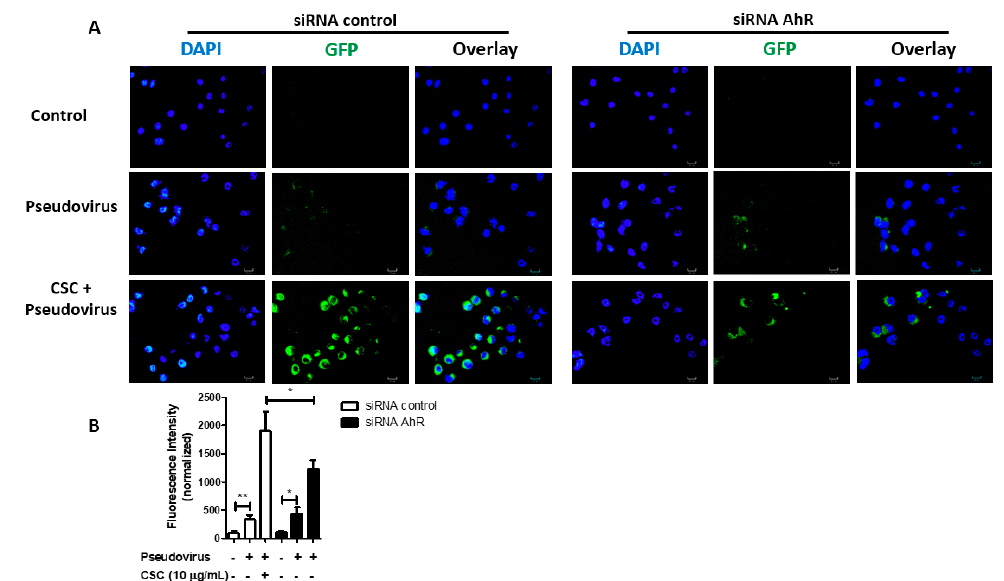
Figure 5. Treatment with cigarette smoke condensates increases severe acute respiratory syndrome coronavirus 2 (SARS-CoV-2) pseudovirus infection in gingival epithelial cells via aryl hydrocarbon receptor (AhR) signaling. Human gingival epithelial cells (GECs) were transfected with siRNA sequences against AhR or an unrelated target, and treated with or without cigarette smoke condensate (10 μ g/mL) for 24 h, prior to infection with SARS-CoV-2 pseudotyped GFP-tagged lentivirus for an additional 24 h. SARS-CoV-2 pseudotyped GFP-tagged lentivirus infection was visualized by immunofluorescence microscopy. ( A ) shows representative images of immunofluorescence for GFP-tagged SARS-CoV-2 pseudovirus. ( B ) Graph shows average percentage ± SEM of GFP fluorescence intensity, measured using Image J. ( A , B ) n = 3. * p ≤ 0.05; ** p ≤ 0.01; Diameter bar = 100 µ m.